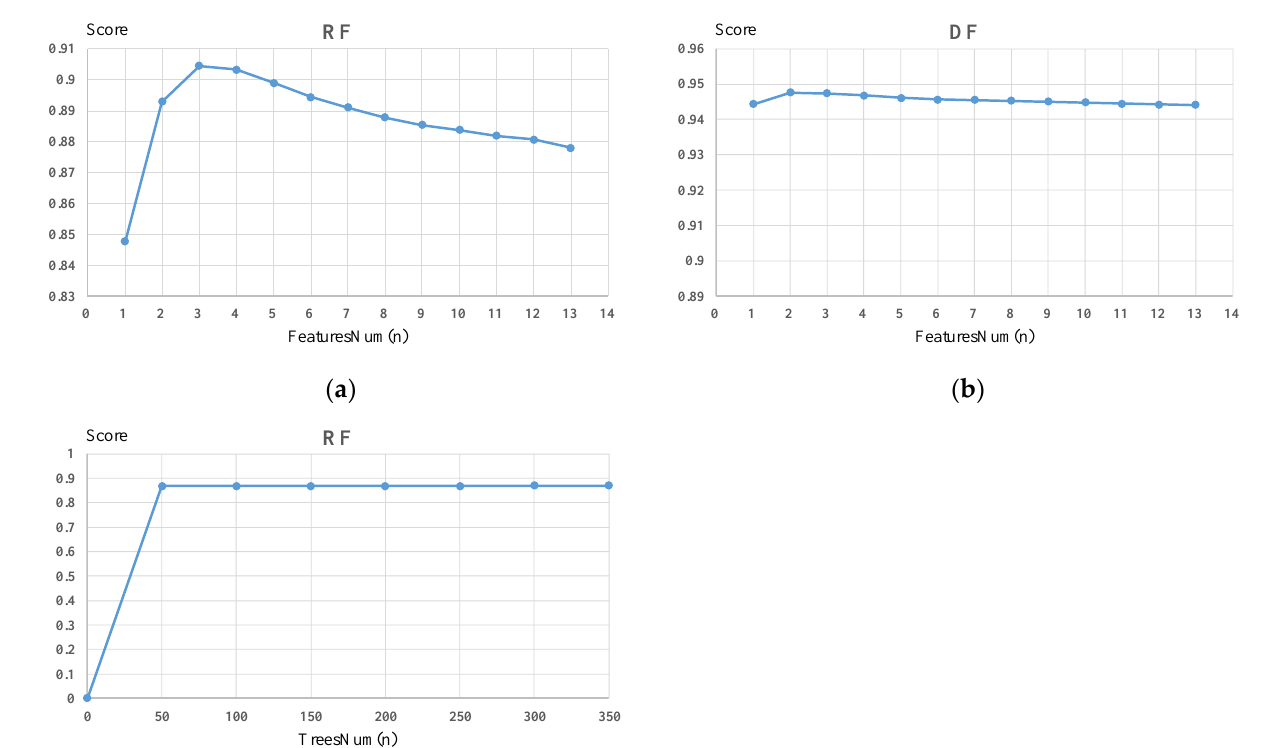
Figure 6. Tuning curves of ( a ) RF with different feature numbers, ( b ) DF with different feature numbers, an ( c ) RF with different tree numbers.